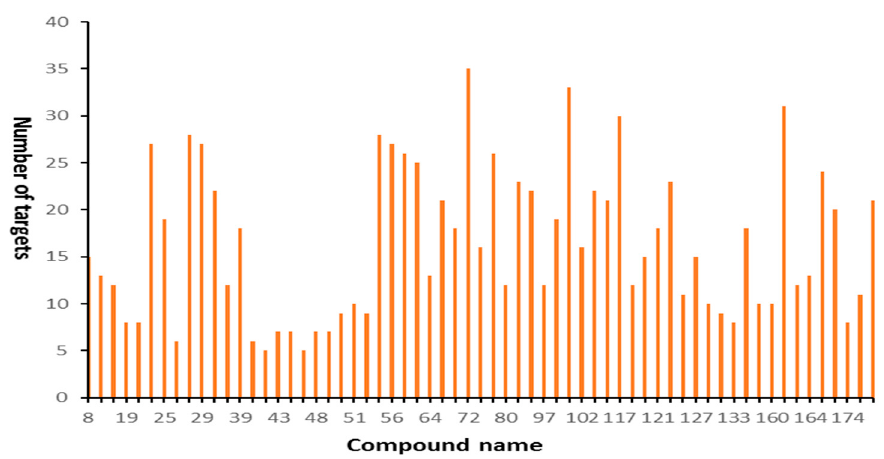
Figure 2. Degree distribution between compounds and putative targets. Table 3. Four compounds with top 4 degree distribution between compounds and putative targets.